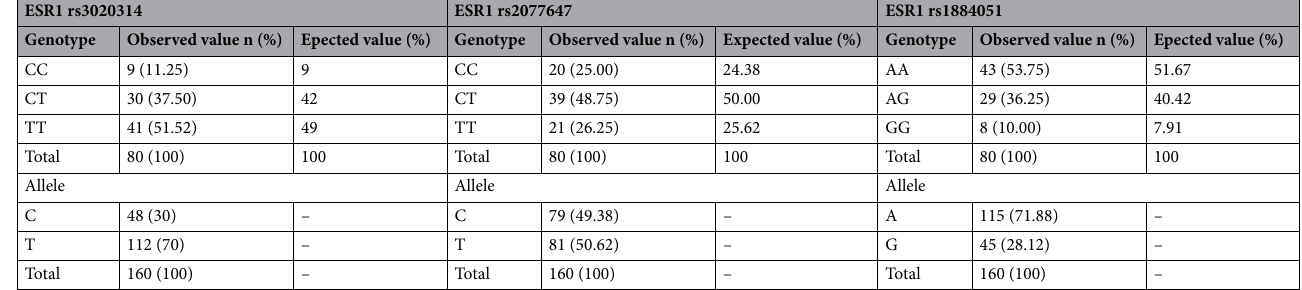
Table 1. The frequency of alleles and genotypes of the ESR1 polymorphisms in women with hyperandrogenism.